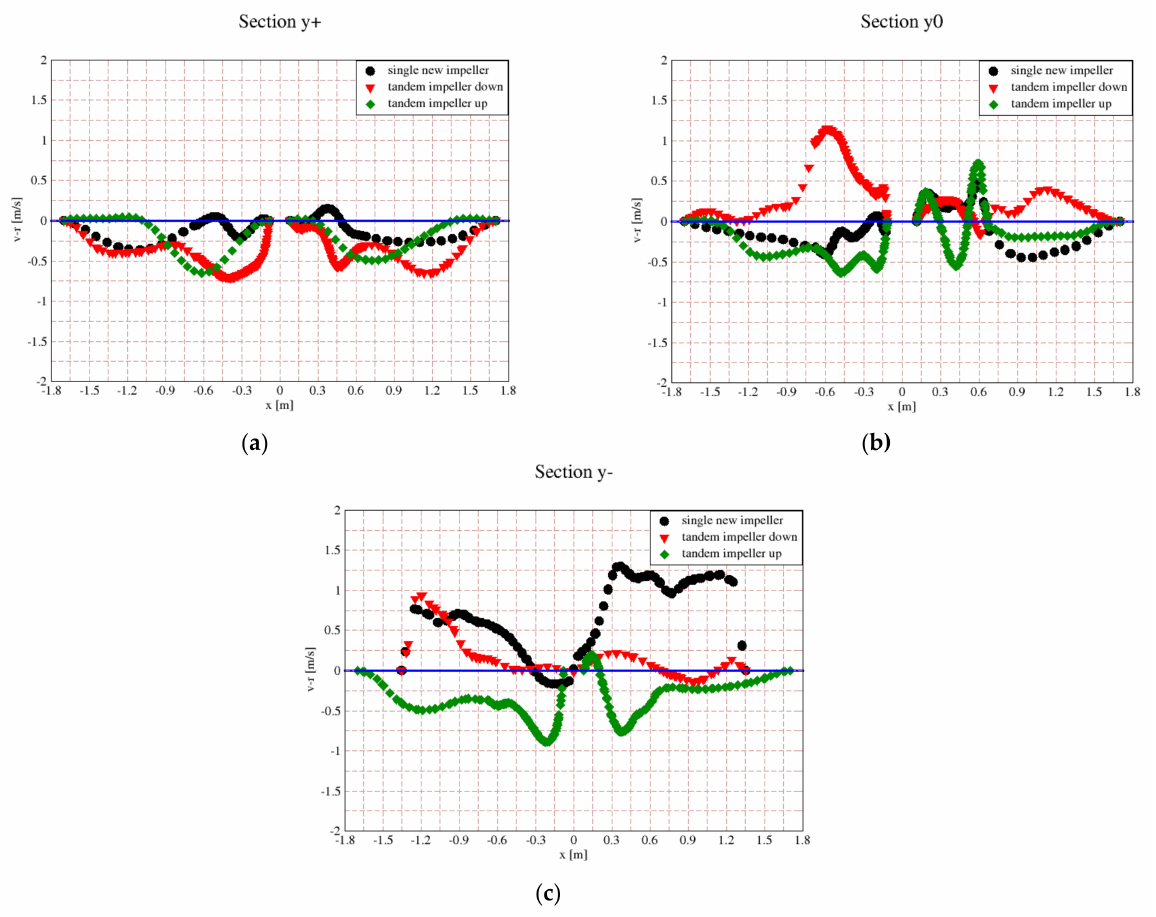
Figure 7. Radial velocity distribution of liquid phase at various axial levels, single new impeller vs. new impellers in tandem, instantaneous results: ( a ) above impeller; ( b ) impeller level; ( c ) under impeller.